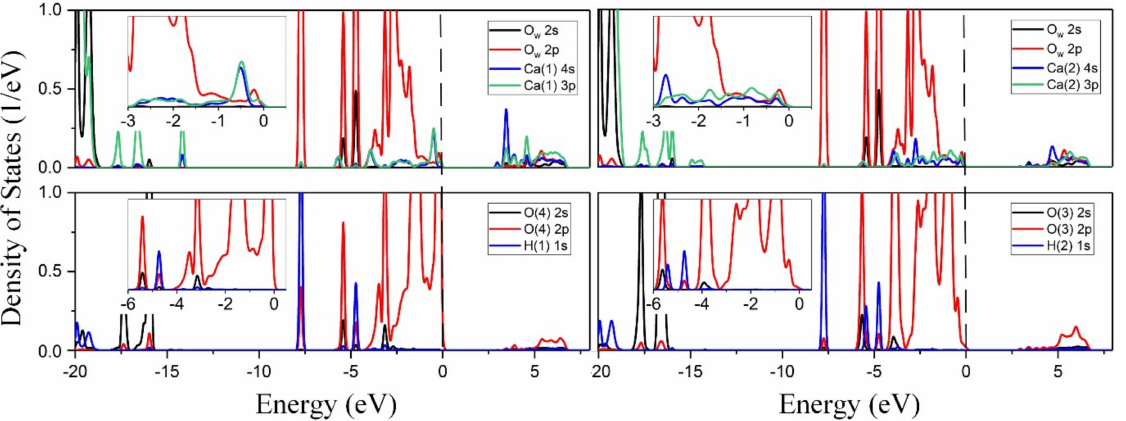
Figure 8. Partial density of states for participating atoms in freshly formed bonds from